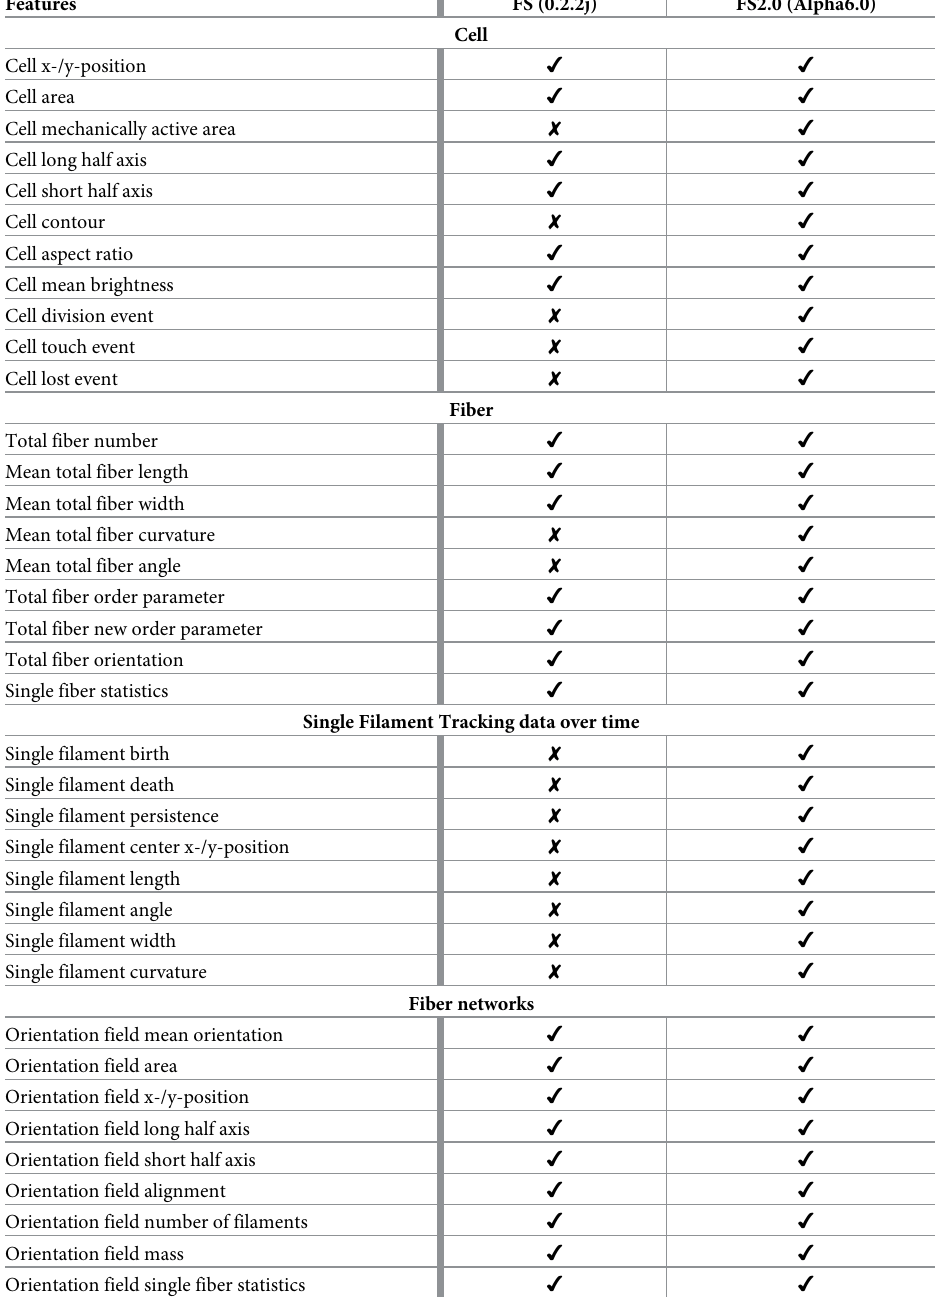
Table 1. Comparison of the feature output of the FS [22] and the novel FS2.0. Features are exported in .csv files by the fiber detection, cell contour feature, and Single Fiber Tracking feature. Features FS